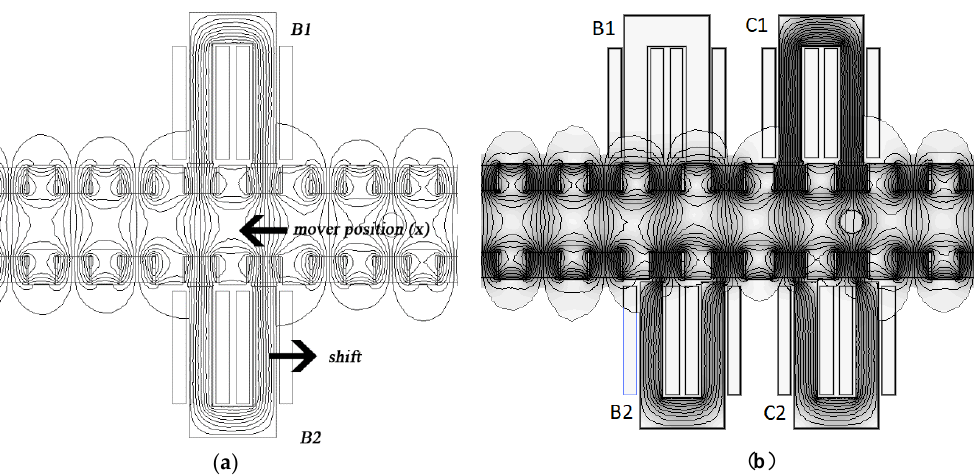
Figure 6. Field line distribution for PM-LHRM, I B = I C = 0 and position x = 0 mm. ( a ) B-phase s =0 mm. ( b ) whole PM-LHRM s =4 mm.